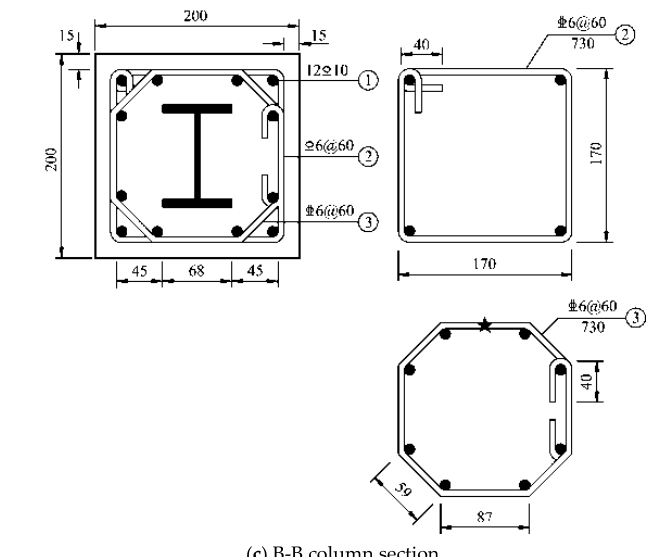
Figure 1. Geometry and reinforcement details of test specimens (units: mm).